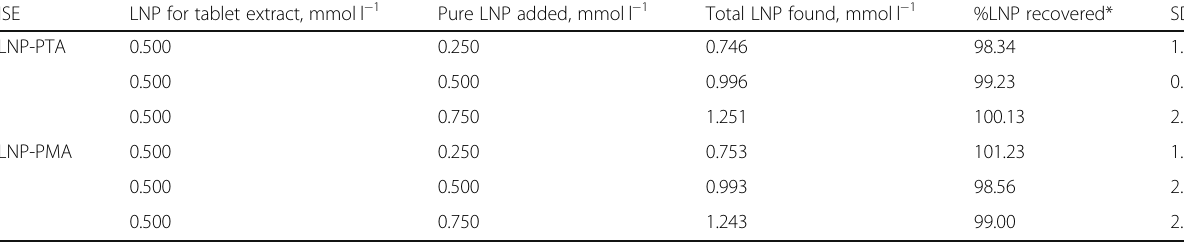
Table 7 Results of accuracy assessment by recovery test for listril tablets